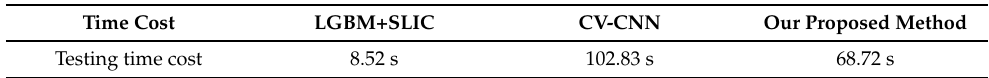
Table 4. Comparison of time cost.